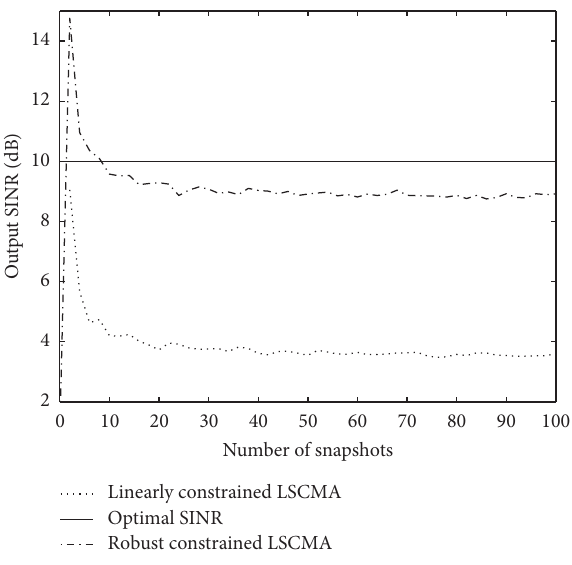
Figure 5: Output SINR versus 𝑁 (in the mismatch case).